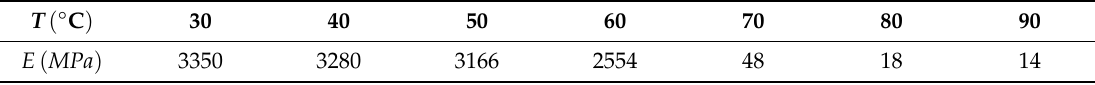
Table 1. The temperature-dependent Young’s modulus from the DMA